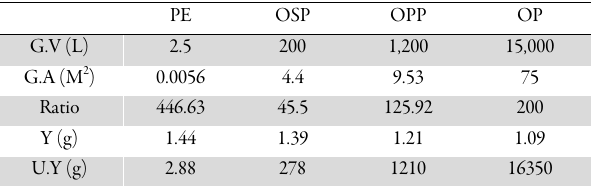
Fig. 4. Dry weight (g.l -1 ) of Spirulina platensis grown within different growth units Table 4. Technical specifications of different growth units affecting growth yield of Spirulina